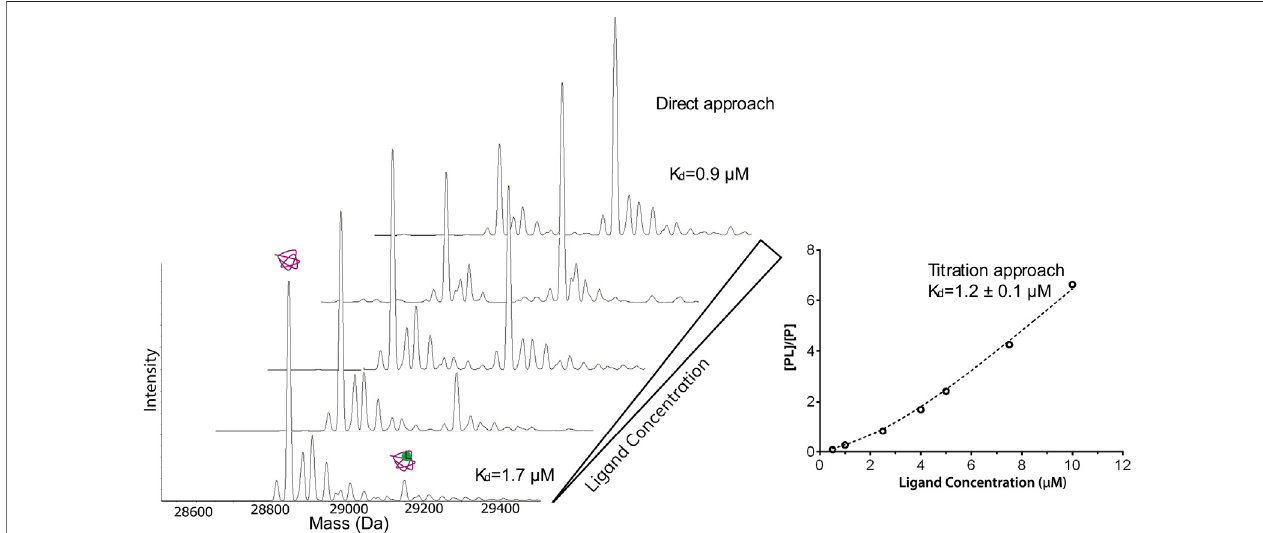
FIGURE 3 | Native ESI-MS spectra and the fi tted curve of titration of dichlorphenamide against 4 μ M carbonic anhydrase I in 50 mM ammonium acetate, 2% dimethylsulfoxide. The concentration of dichlorphenamide was varied. The measured K d from the titration curve was 1.2 μ M which is in good agreement with the values calculated based on a single spectrum using the direct approach (1.7 and 0.9 μ M) and published values.